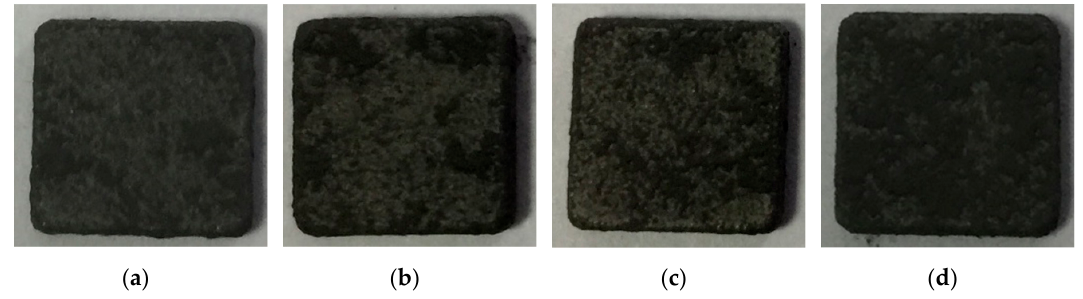
Figure 2. Images of steel substrates milled with NiAl and CrB 2 powders for: ( a ) 4, ( b ) 8, ( c ) 16, and ( d ) 32 h.